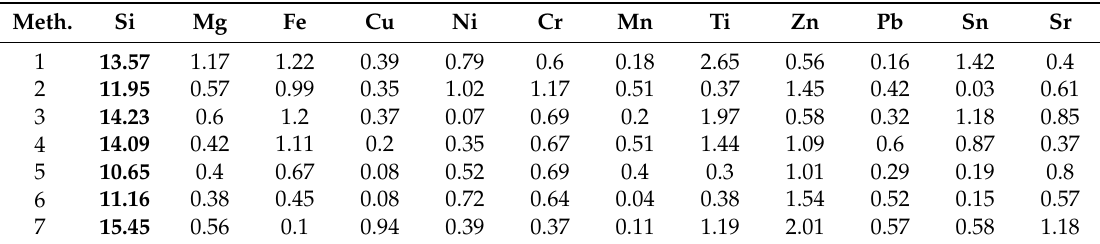
Table 3. The student “t” coefficients for T DCP .